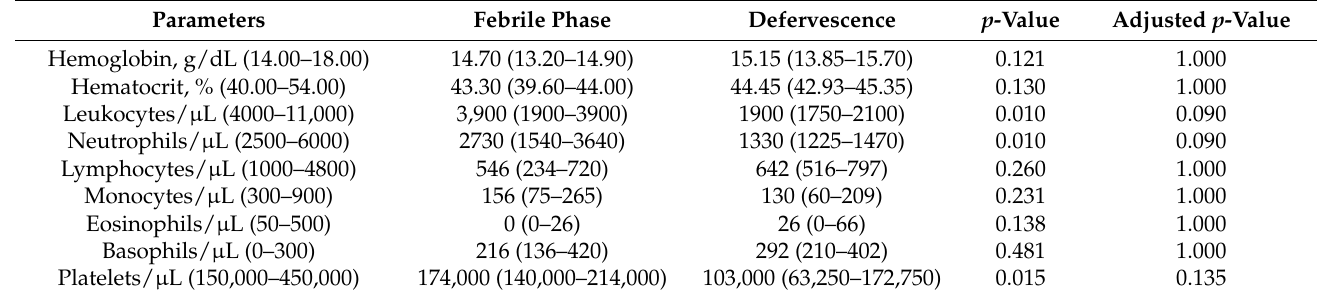
Table 2. Hematological profile during the febrile and defervescent phases of dengue infection.